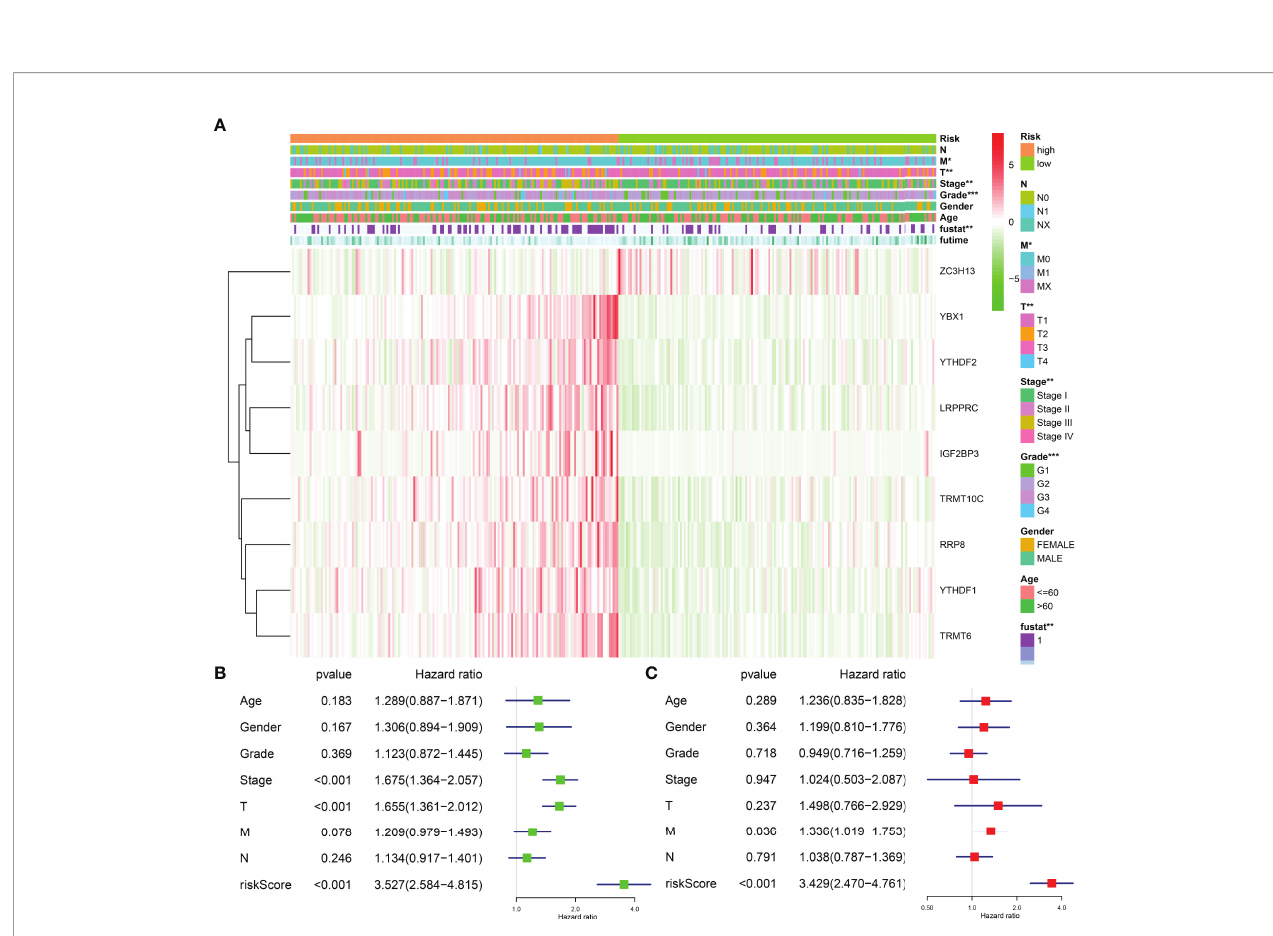
FIGURE 8 | The correlation between risk model and the prognosis and clinicopathological characteristics of HCC patients. (A) The relationships between the clinicopathological features and risk model. (B, C) Univariate and multivariate Cox regression analyses for the prognostic factors of HCC patients. HCC, hepatocellular carcinoma; *P < 0.05; **P < 0.01; ***P < 0.001.